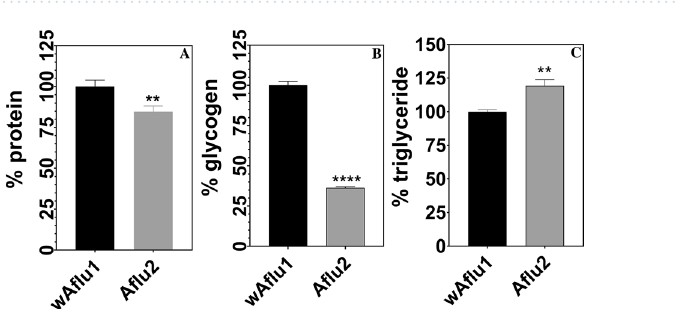
Figure 3. w Aflu1 has a more peripheral actin distribution than Aflu2. w Aflu1 and Aflu2 cell morphology was observed under a confocal laser scanning microscope, Zeiss LSM 710. Actin cytoskeletal morphology (green) and nuclei (blue) were observed three days after subculture using Phallacidin and DAPI staining, respectively. wAflu1 cell line has more peripheral actin distribution (red arrow head and detailed view in zoomed image) than Aflu2 (white arrow head). Scale Bar: 10 µm.